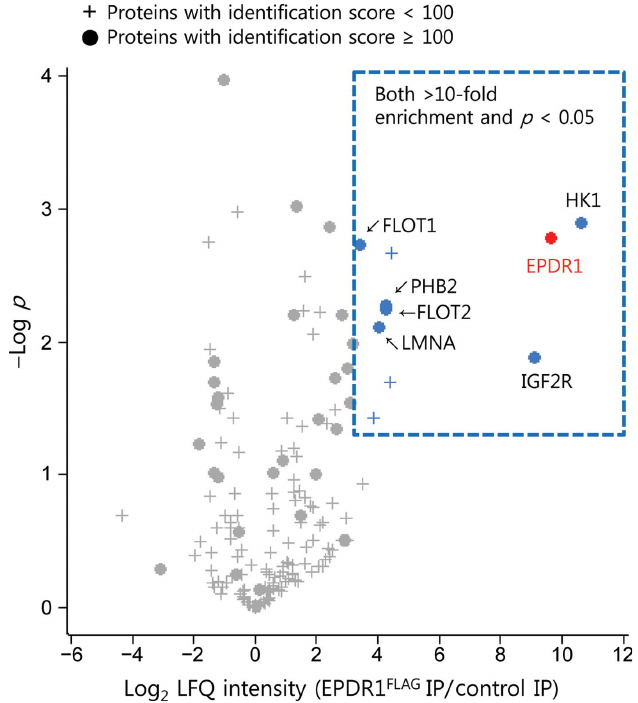
Figure 6 Volcano plot for the proteins quantified by EPDR1 FLAG immunopreci- pitation–mass spectrometry (IP-MS). LFQ intensity values for EPDR1 (depicted as a red circle) and six other proteins (blue circles) increased in anti-FLAG IP-MS over control IP-MS (>10-fold, p < 0.05 after Student’s t-test). To calculate the statistical significance, LFQ intensity values for proteins that were not quantified in control IP-MS were replaced by random numbers drawn from a normal distribution (width, 0.3; down shift, 1.8) using Perseus . The protein-identification score determined by MaxQuant was applied to filter out proteins that are likely to be false- positive